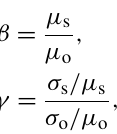
Figure 2 maps the mean daily river discharge from 1979 to 2018 for each GloFAS river with an upstream area greater than 1000 km 2 , revealing the main river arteries of the